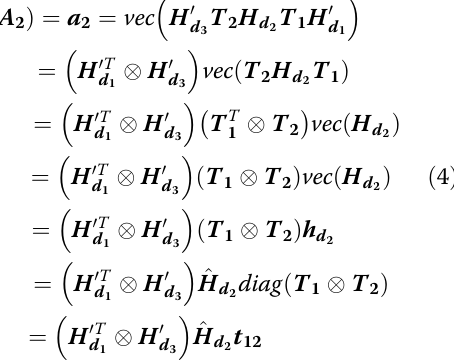
complex-valued linear transformation vectors forms a 2 N − 1-dimensional subspace of an N 2 -dimensional vec- tor fi eld. The Supplementary Information (Section S1 and Table S1) also provides a coef fi cient and basis vector generation algorithm, independently reaching the same conclusion that this special case forms a 2 N − 1-dimen- sional subspace of an N 2 -dimensional vector fi eld. The upper limit of the solution space dimensionality that can be achieved by a two-layered diffractive network is N 2 which is dictated by the input and output FOVs between which the diffractive network is positioned.